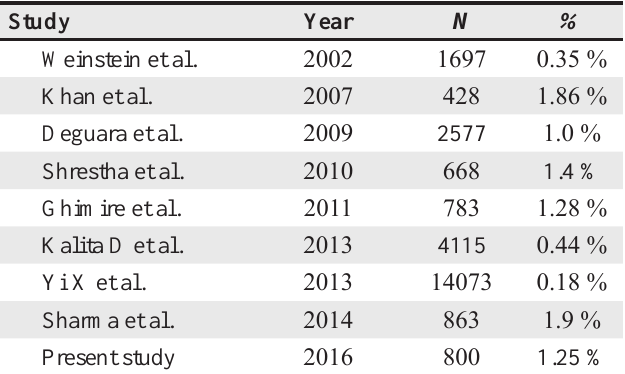
Table 3 : Comparison of occurrence of incidental gallbladder carcinoma with different studies.